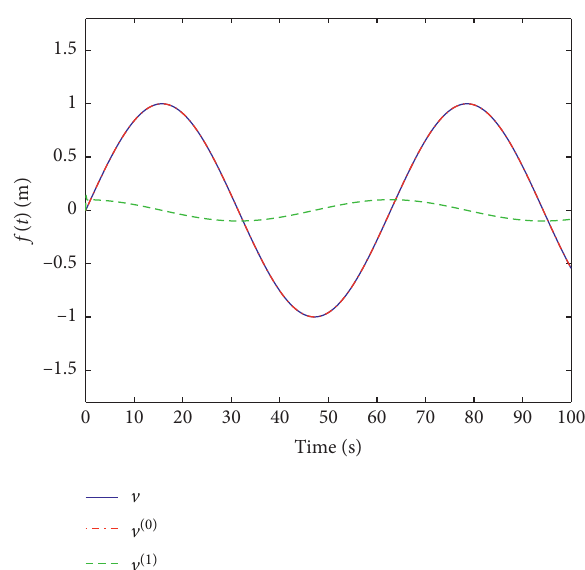
Figure 5: TD trend chart of sin ( 0 . 1 t )